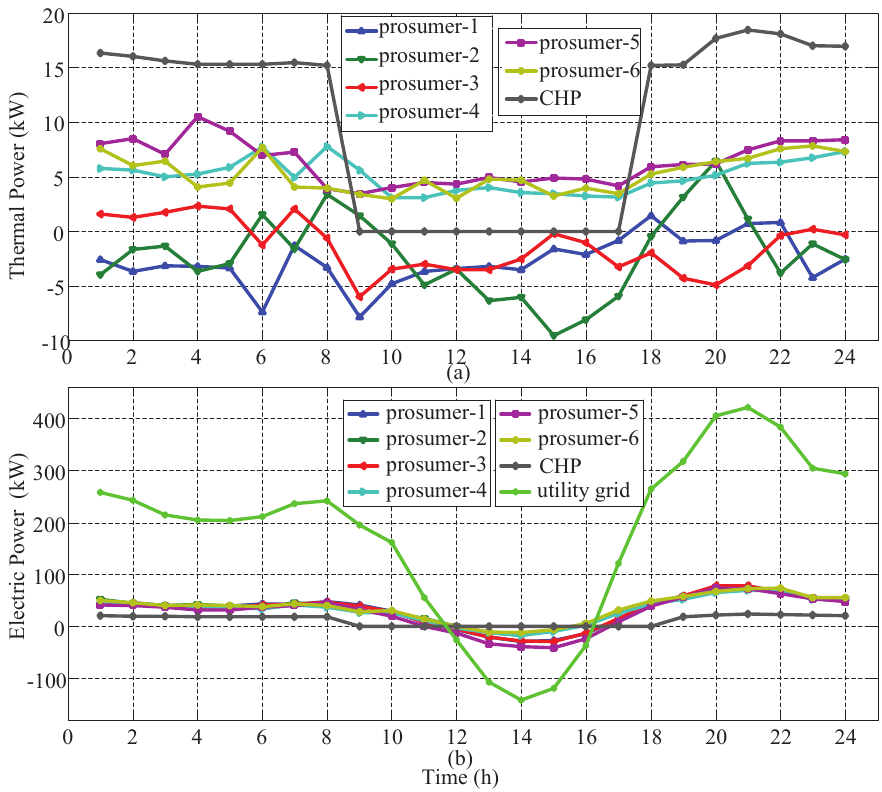
Figure 7. Net power during the day. ( a ) Net thermal power; ( b ) Net electric power.